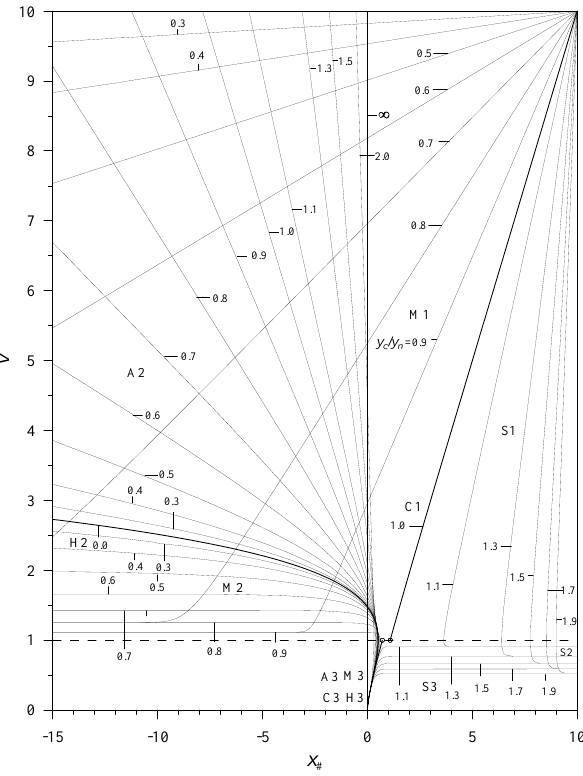
Figure 1. A plot of the y c -based dimensionless 1-D GVF profiles for M = 3 and N = 10/3 with y c / y n as a parameter.